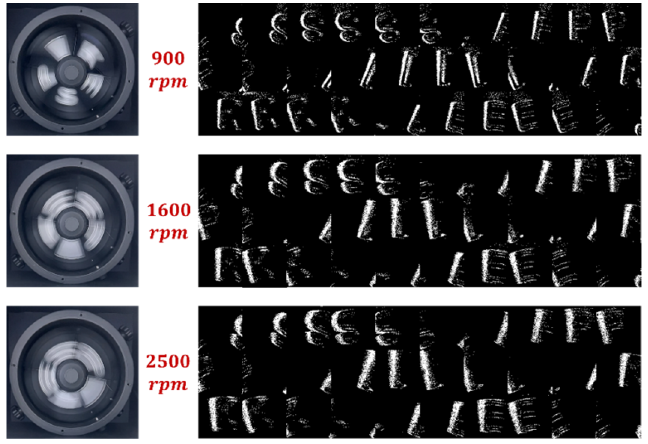
Figure 7. RGB images captured by a frame-based camera and event slices captured by the DVS at different speeds. Event slices aggregated by OR logic aggregation algorithm contain clear letter edges at all rotating speeds, while for RGB images, the motion blur gets worse as the rotating speed rises.